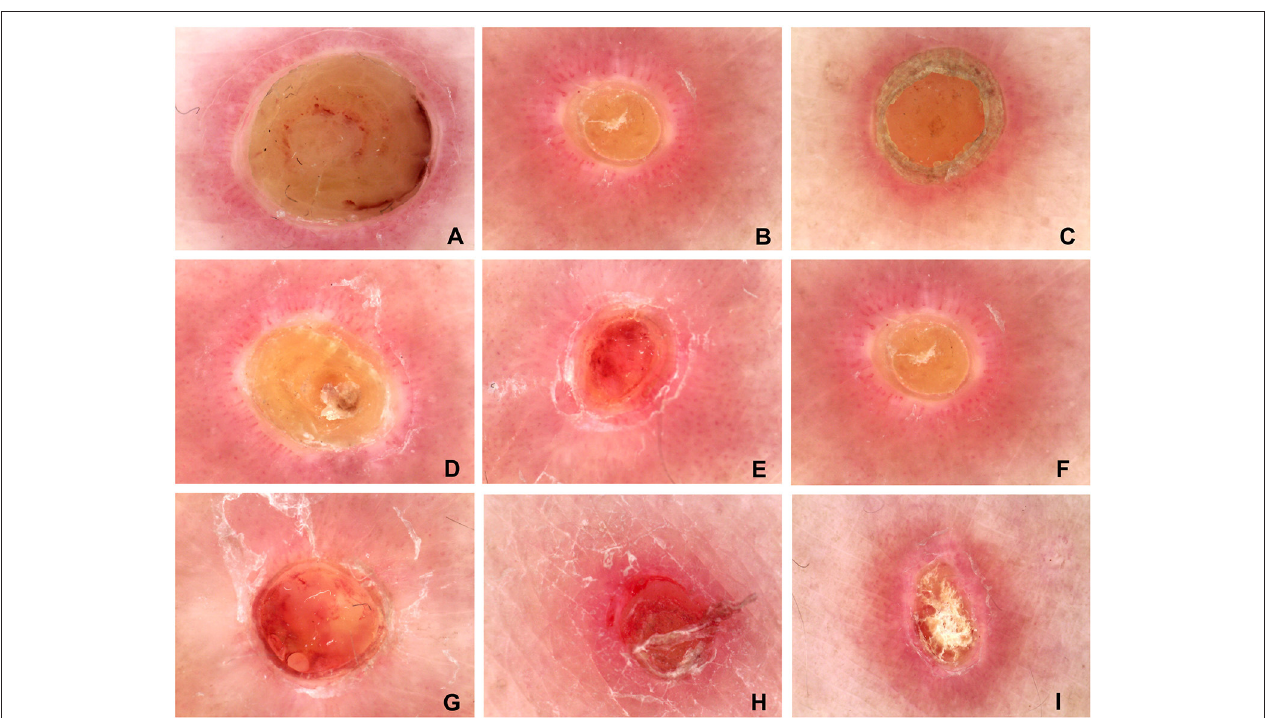
FIGURE 3 | The common dermatoscopic features of the typical lesions from the 39 patients. (A) the yellow-brown homogeneous structureless area in the center of the lesion; (B) dotted and linear vessels distribution radially; (C) a dam shape uplift at the periphery of the lesion; (D) the white irregular halo surrounding the lesion; (E) a thin scale ring surrounding the lesion; (F) pink background; (G) orange background; (H) red background; (I) pigment structure surrounding the lesion. (A–D) the four common dermoscopic features of APD.